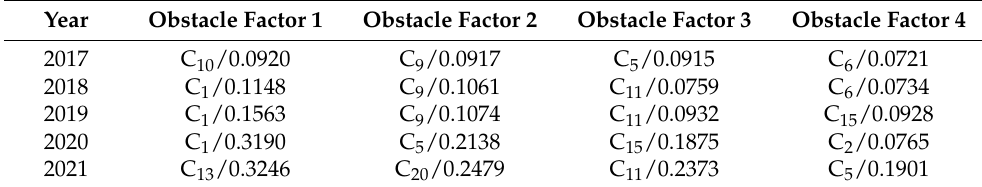
Table 7. Analysis of Obstacles of Evaluation Indicators in